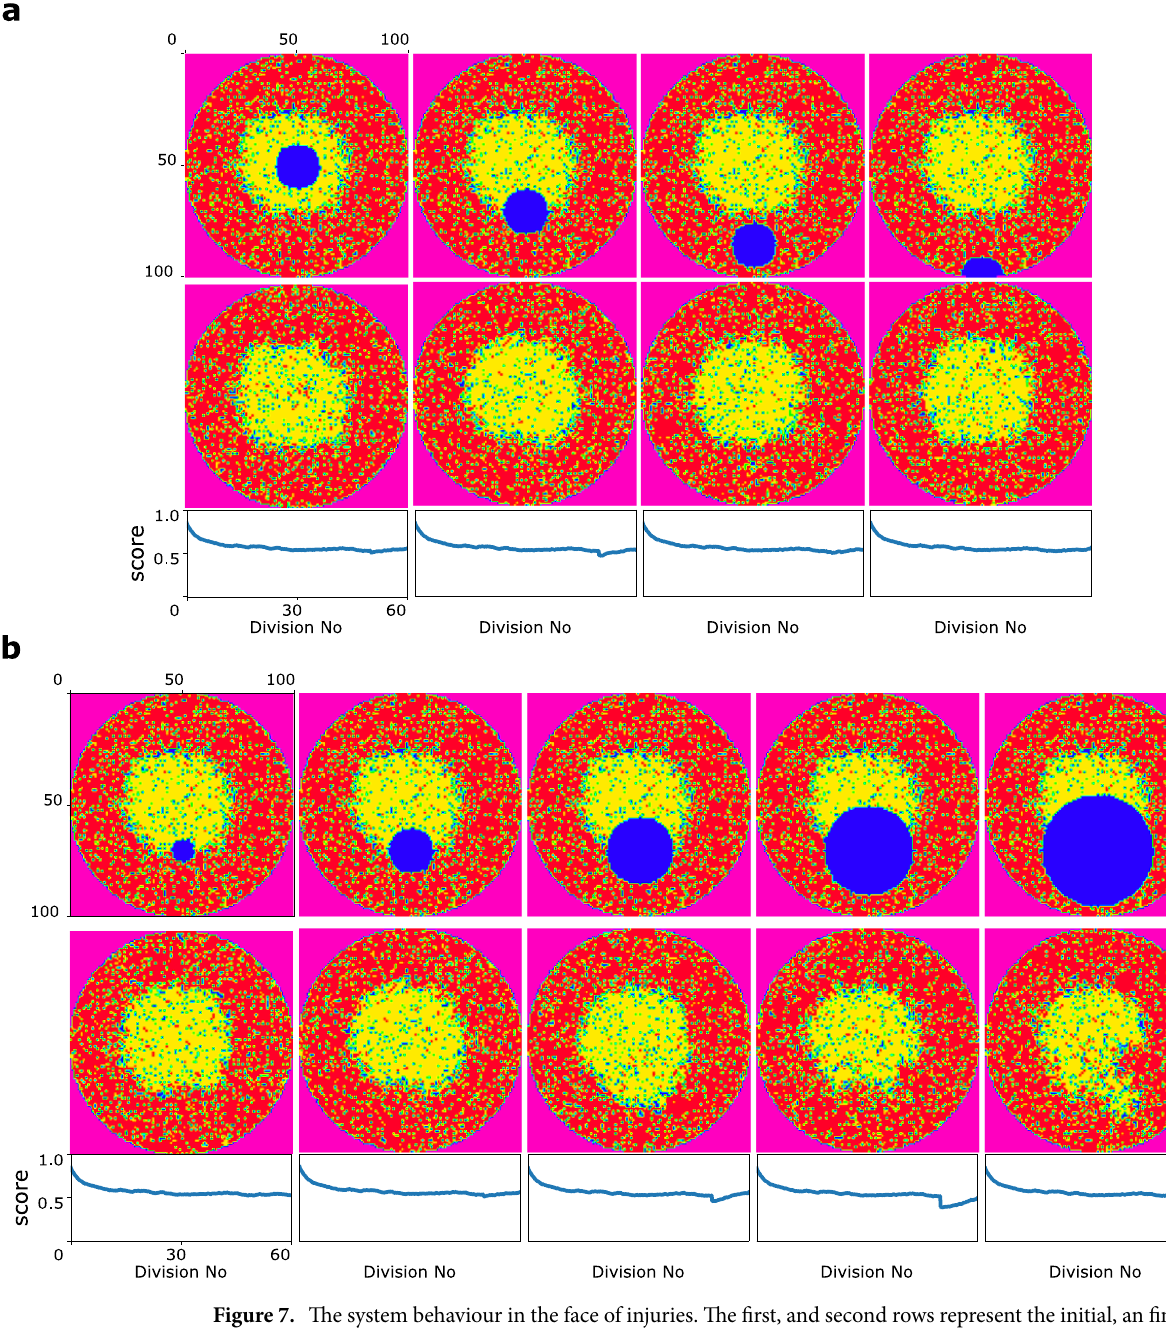
Figure 7. The system behaviour in the face of injuries. The first, and second rows represent the initial, an final states of the system, respectively. The corresponding score diagram of five mentioned simulations are shown in the last row. ( a ) Injuries in different regions in the population. ( b ) Injuries with different regions